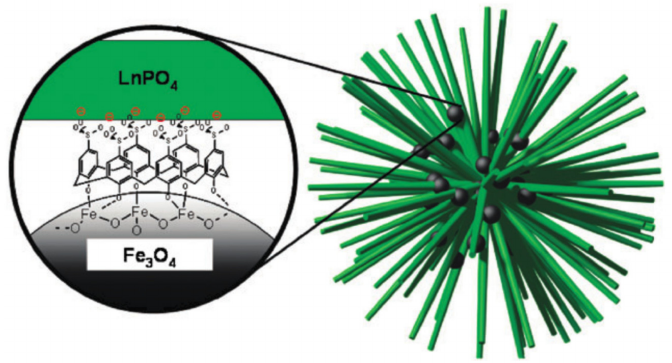
Figure 8. A schematic representation of the nanoball structure of LnPO 4 nanorods (Ln = La, Eu, Tb, Ce) held together by p -sulfonato-calix[6]arene stabilised Fe 3 O 4 nanoparticles. Reproduced by permission of The Royal Society of Chemistry from